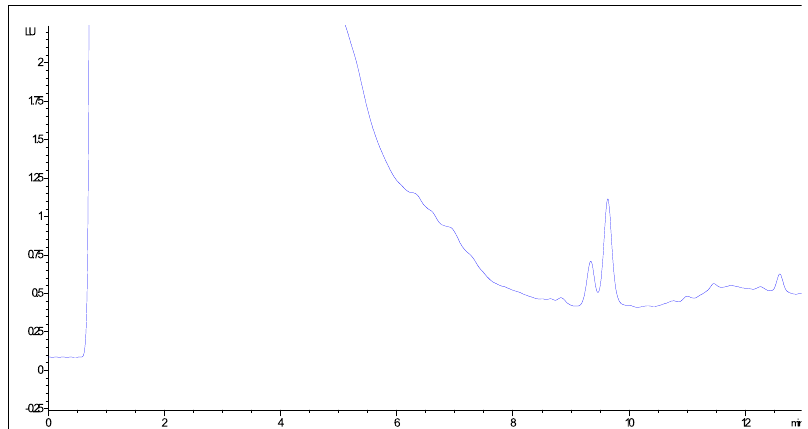
Figure 3. Chromatogram obtained by HPLC-FLD with a blank sample of “sweet corn”: luminescence unit (LU) vs. retention time (min).